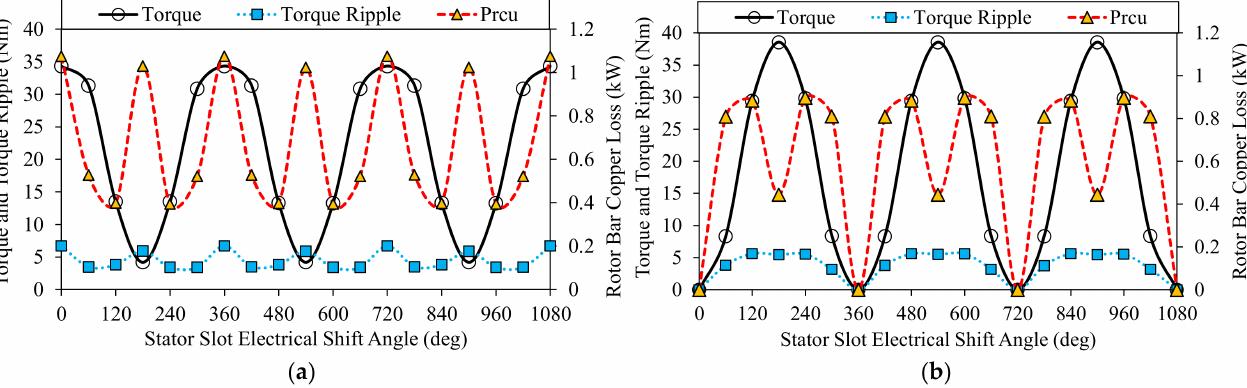
Figure 10. Variation of torque, torque ripple, and rotor bar copper loss with shift angle α : ( a ) while the both winding sets are in positive polarization ( + , + ) and ( b ) while the 1.set is in positive and 2.set is in negative polarization ( + , −